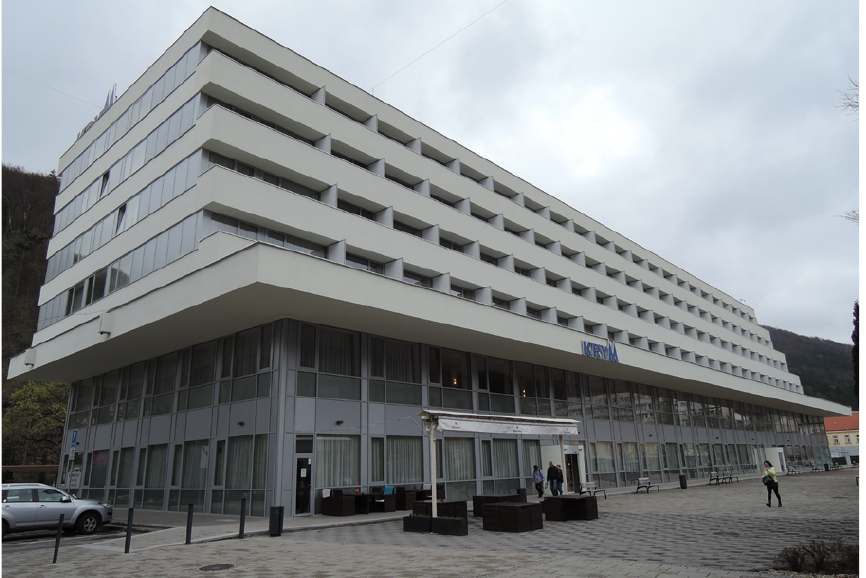
Fig. 9 Architect: Milan Šavlík, Krym Hotel (after restoration), Trenčianske Teplice, Slovakia, 1974-1976. Construction: Neimar, Belgrade (Photo: Jelica Jovanović,